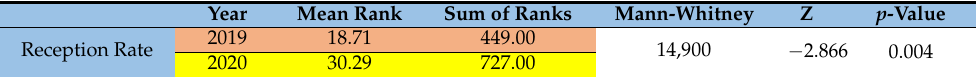
Table 3. The output of the Mann-Whitney